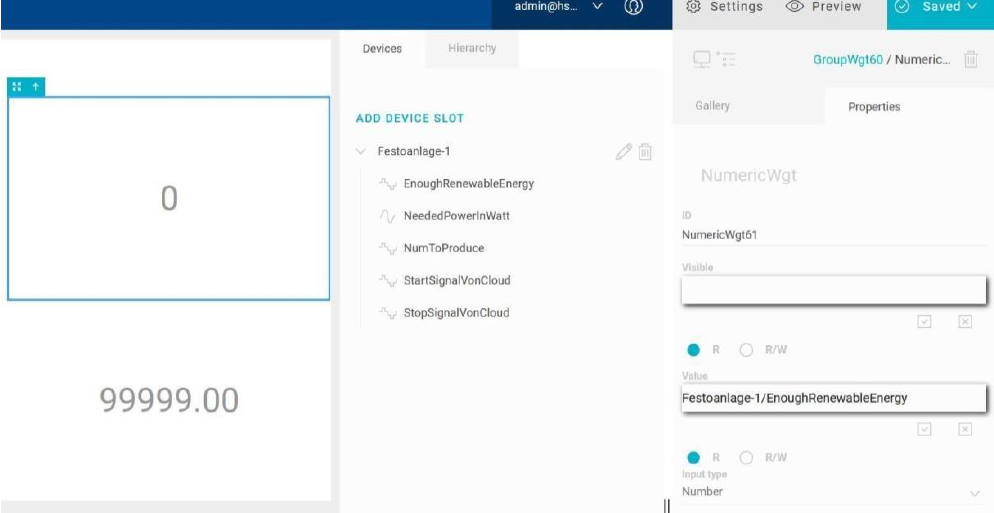
Figure 4. Web interface of the cloud